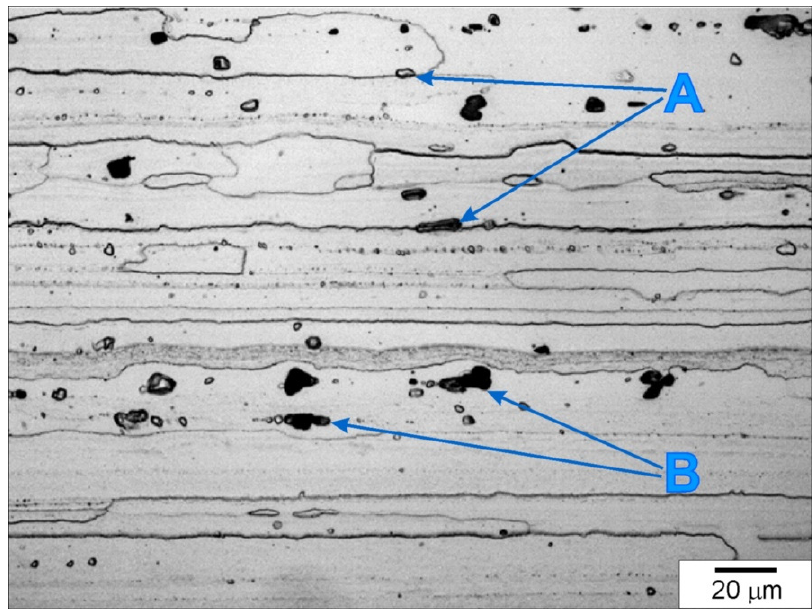
Figure 6. Microstructure of 7075 aluminum alloy in initial state, light microscope, etched specimen.